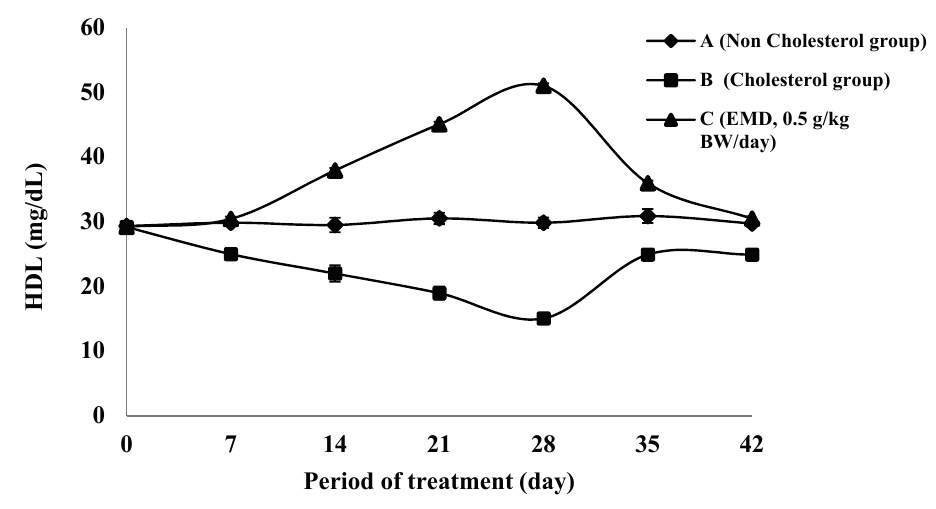
Figure 4. The changes of HDL-cholesterol level during treatment on groups of non-cholesterol (A) ( ♦ ); cholesterol (B) ( ■ ); and EMD 0.5 g/kgbw (C) ( ▲